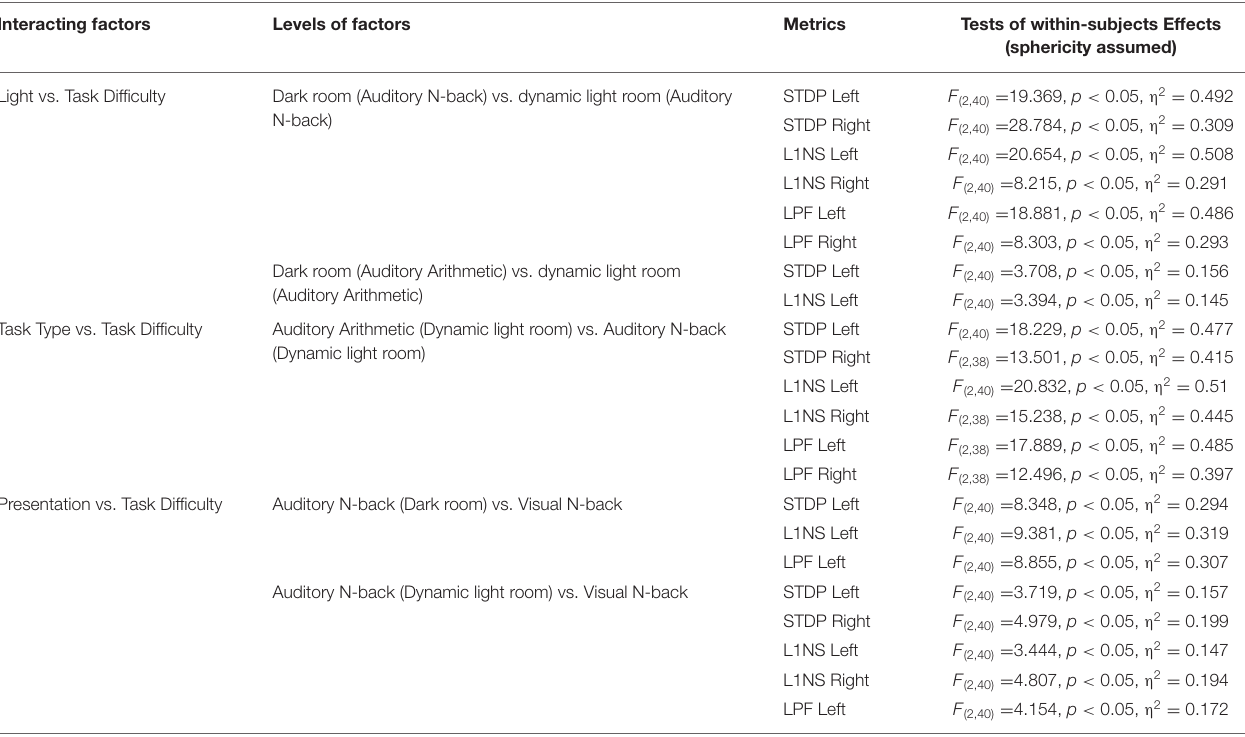
TABLE 7 | Tests of within-subjects effects.